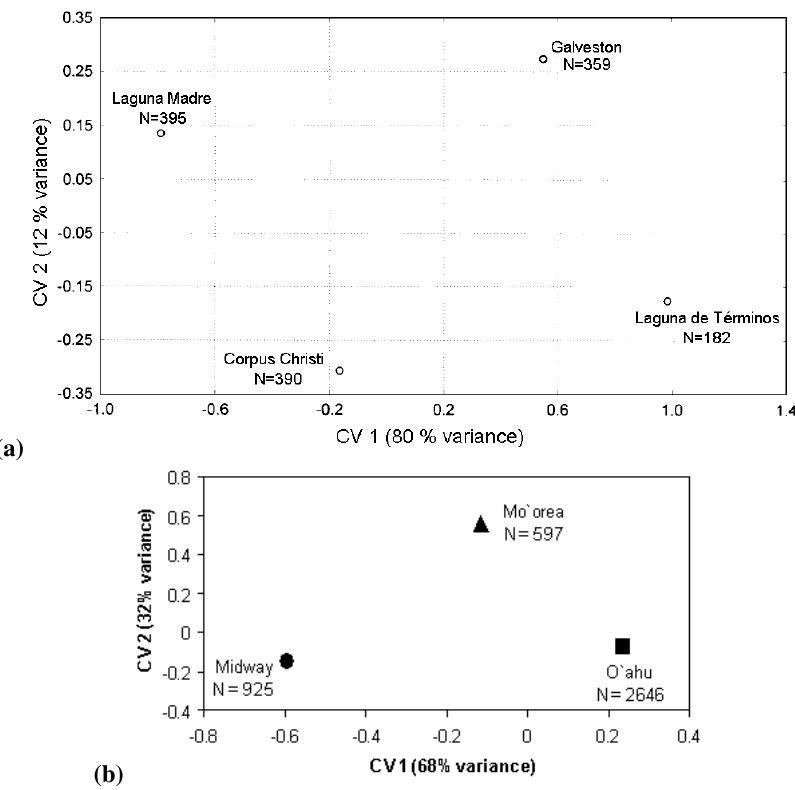
Fig. 2 – Means of the canonical variates (CV) for the between-group pairwise comparison of (a) Bottlenose and (b) Spinner Dolphin whistles. For the compar- ison of Bottlenose Dolphin whistles, only the first 2 CV were